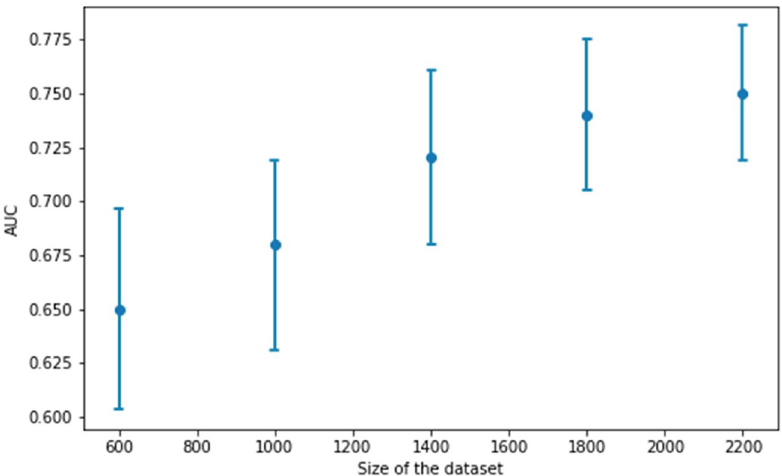
Figure 4. The relationship between the size of the data set and the model performance. The blue dot represents the area under the ROC curve value and the vertical lines show the corresponding confidence intervals.